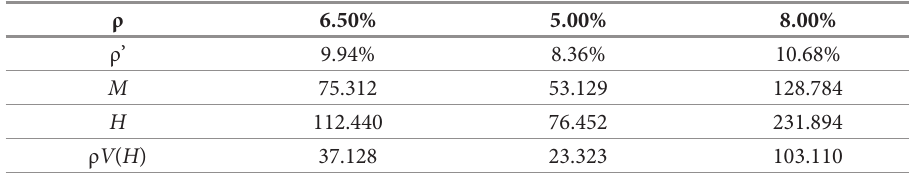
Table 6. Sensitivity analysis of the discount rate of return **